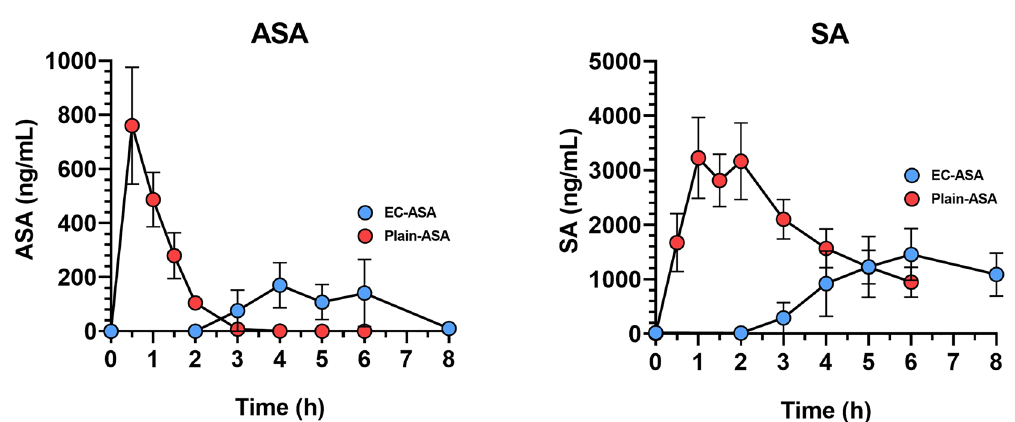
Figure 5. Mean pharmacokinetics curves after oral administration of 100 mg EC-ASA (blue) and plain-ASA (red) to HS (n = 6). The curve after EC-ASA administration includes the subject with no